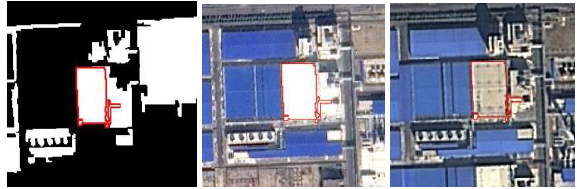
Figure 5. Candidate Change Regions Obtained by Improved Levene-Test (Dark Areas)